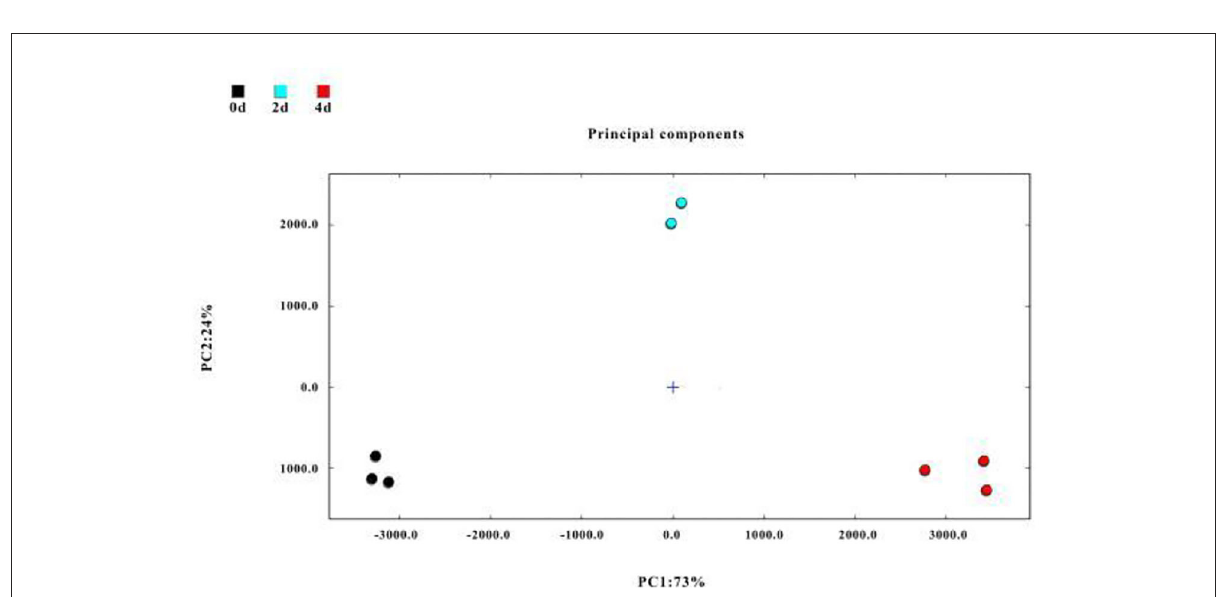
FIGURE5 Principal component analysis (PCA) of flavor compounds in hairtails during the air-drying